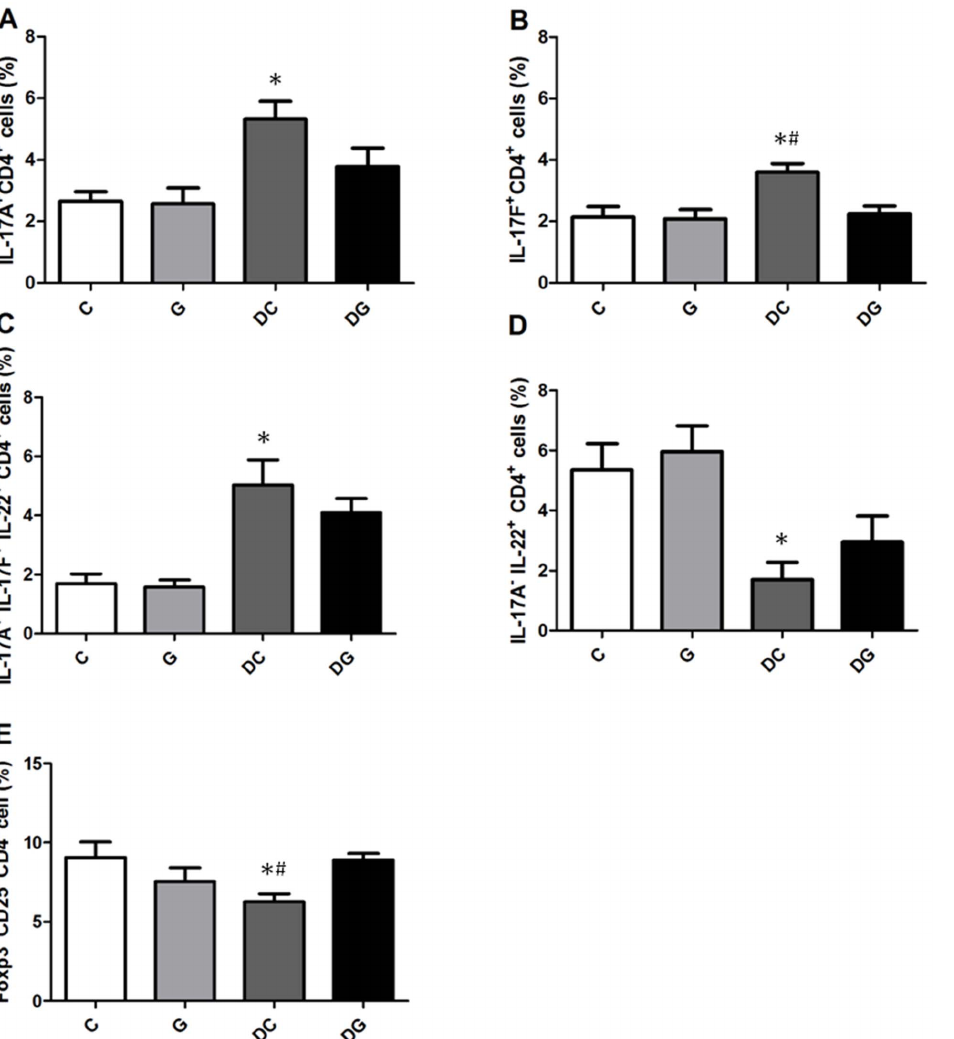
Figure 2. Percentages of Th17/Th22-associated cytokine-producing cell and Treg cell populations in the blood. CD4-positive lymphocytes were gated to analyze intracellular cytokine expressions by flow cytometry. A: Expression of intracellular interleukin (IL)-17A. B: Expression of intracellular IL-17F. C: Triple expression of intracellular IL-17A, IL-17F, and IL-22. D: IL-22 + and IL-17A 2 Th cells. E: Percentage of Treg cells. Data are presented as the mean 6 SEM. Differences among groups were analyzed by an ANOVA using Tukey’s test. *Significantly differs from the C group. # Significantly differs from the DG group ( p , 0.05).